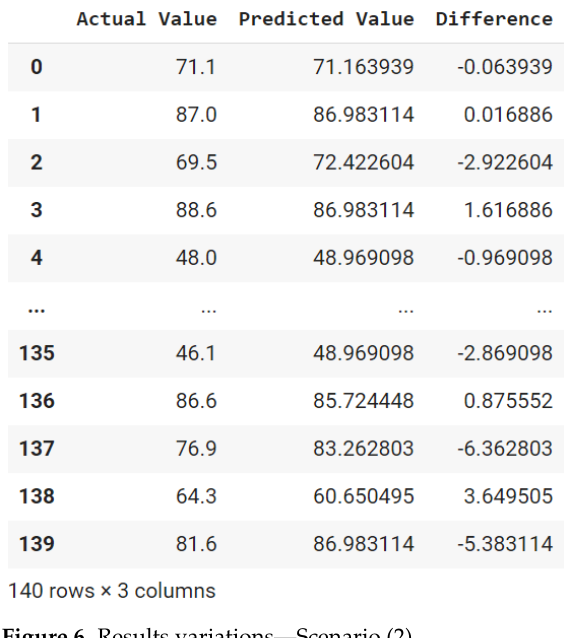
Figure 6. Results variations—Scenario (2).